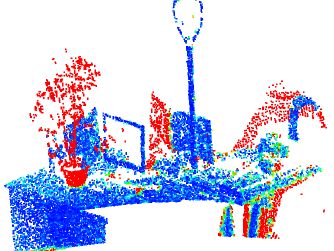
Figure 11: Registration accuracy for the TLS dataset (optimal configuration), colored according to ¯ t (0 m (blue) → 1 cm and more (red)).